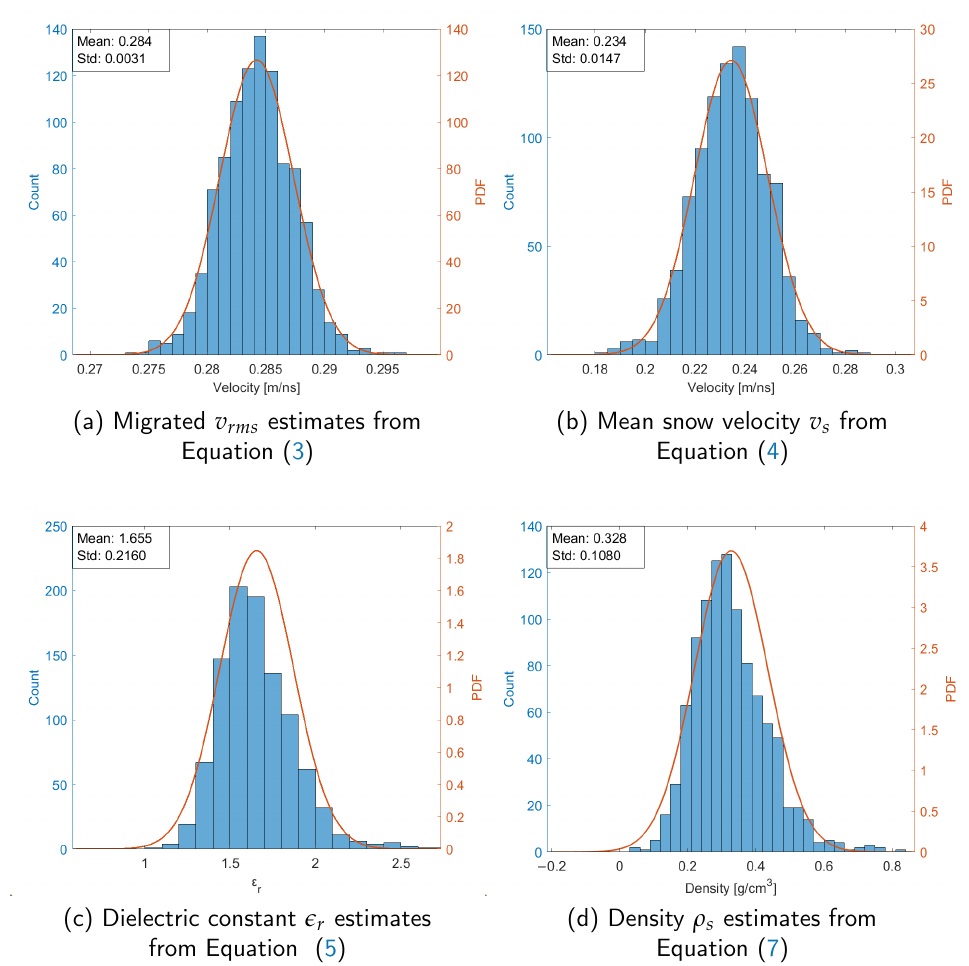
Figure 5. Combined altitude and distance errors’ influence on estimators derived by Monte Carlo